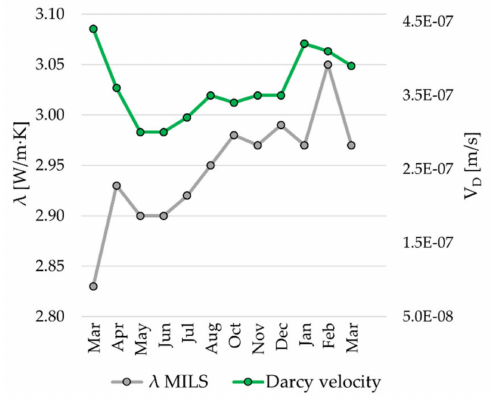
Figure 5. Correlation of thermal conductivity values λ calculated via moving-infinite-line-source model and calculated Darcy velocities V D for groundwater flow using this very model; connecting lines do not represent collected data but are used for unambiguous